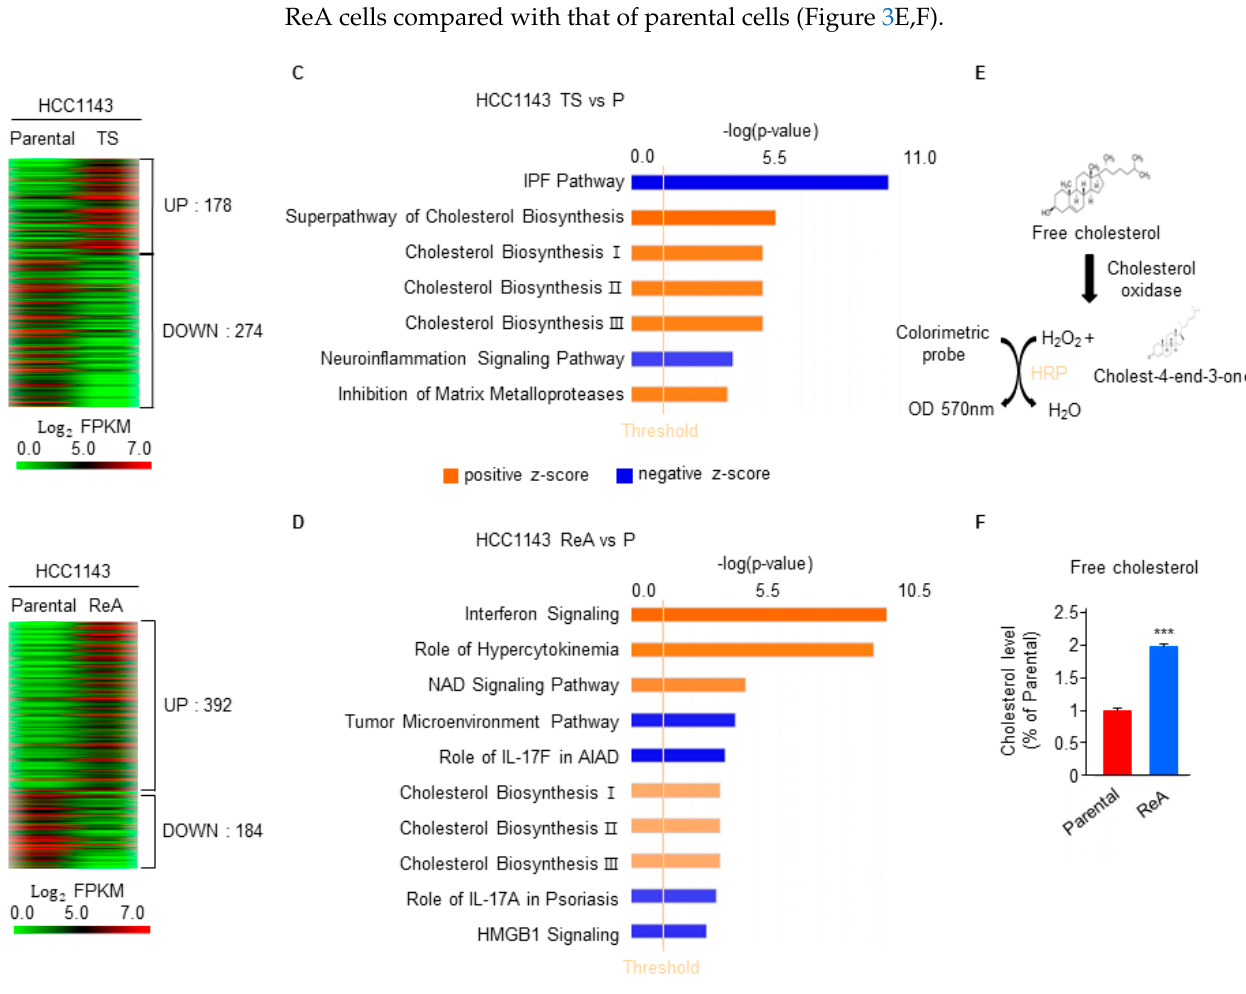
Figure 3. Cholesterol synthesis is upregulated in ReA cells compared with parental cells. ( A , B ) Differentially expressed genes (DEGs) between parental and TS-cultured cells, and parental and ReA cells were analyzed by RNA sequencing. DEGs with expression levels altered more than two-fold are shown as heatmaps produced using a Multi-Experiment Viewer. ( C , D ) The major signaling pathways among the DEGs were analyzed via ingenuity pathway analysis. The pathways with absolute values of z-scores of at least 2 and a -log( p -value) of at least 1.3 are shown. IPF—Idiopathic pulmonary fibrosis signaling pathway; cholesterol biosynthesis II—cholesterol biosynthesis II (via 24,25-dihydrolanosterol); cholesterol biosynthesis III—cholesterol biosynthesis III (via desmosterol); role of hypercytokinemia—role of hypercytokinemia/hyperchemokinemia in the pathogenesis of influenza; role of IL-17F in AIAD—role of IL-17F in allergic inflammatory airway diseases. ( E ) Colorimetric cholesterol assay principle. ( F ) Lipids in HCC1143 parental and ReA cells were extracted, and free cholesterol was measured. Relative levels of free cholesterol were represented as the mean ± standard deviation of two independent experiments ( n = 5). *** p < 0.001 relative to parental